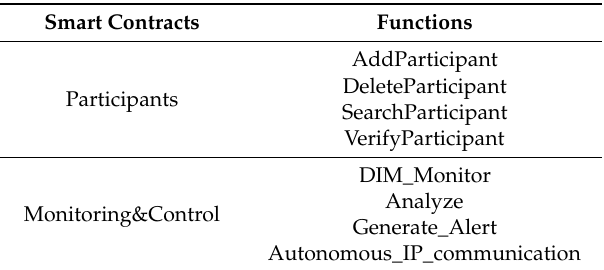
Table 2. Types of smart contracts and their functions.